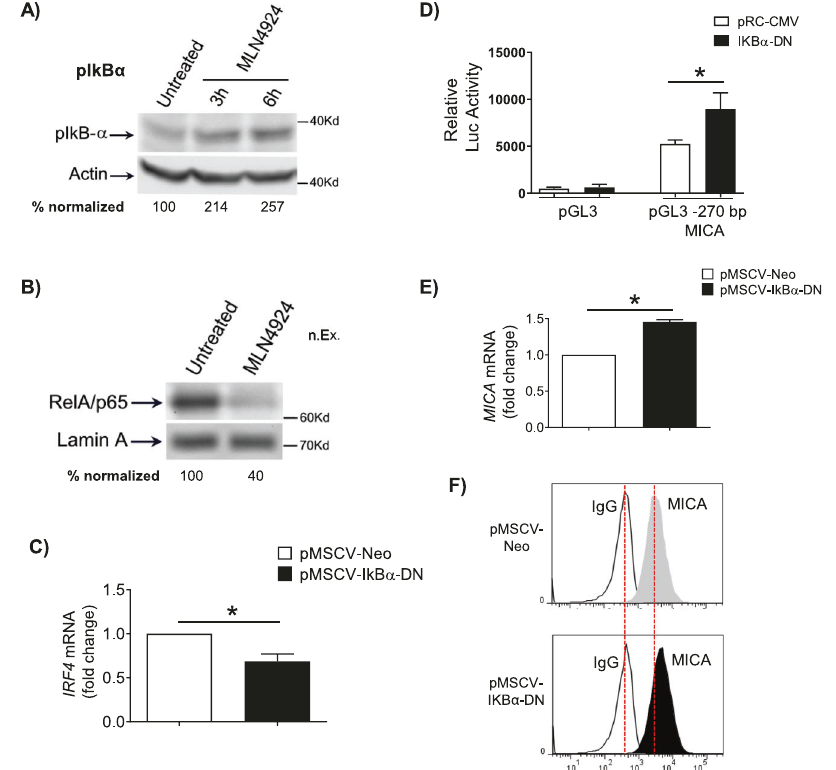
Fig. 6 Role for neddylation in the regulation of the NF-kB/IRF4/MICA axis. A MLN4924 (200 nM) stabilized the expression of pIkB α and B ) repressed nuclear translocation of p65/RelA in SKO-007(J3) cells treated for 48 h. Data are representative of one out of two independent experiments. Densitometric analyses of normalized pIkB α or p65/Actin are shown. C IRF4 mRNA levels were quanti fi ed by Real-time PCR in SKO-007(J3) cells overexpressing a dominant-negative form of IkB α (IkB α -DN) or the empty control vector pMSCV-Neo. Data, expressed as fold change units, were normalized to GAPDH, and referred to the pMSCV-Neo infected cells considered as calibrator and represent the mean (± SEM) of 3 experiments (* P < 0.05). D SKO-007(J3) cells were transiently cotransfected with the indicated MICA promoter deletion and an expression vector for IkB α -DN (S32A/S36A) or the empty control vector (pRc-CMV). Results are expressed as Relative Luciferase activity normalized to protein concentration as well as to Renilla activity produced off the internal control plasmid and represent the mean value (±SEM) of three independent experiments (* P < 0.05). E – F MICA mRNA and cell surface expression were analyzed in SKO-007(J3) cells overexpressing a dominant-negative form of IkB α (IkB α -DN) as described above. Data shown in ( E ), expressed as fold change units, were normalized to GAPDH and referred to the pMSCV-Neo infected cells considered as calibrator, represent the mean (±SEM) of 3 experiments (* P < 0.05). A representative FACS analysis of MICA expression in infected cells is shown in ( F